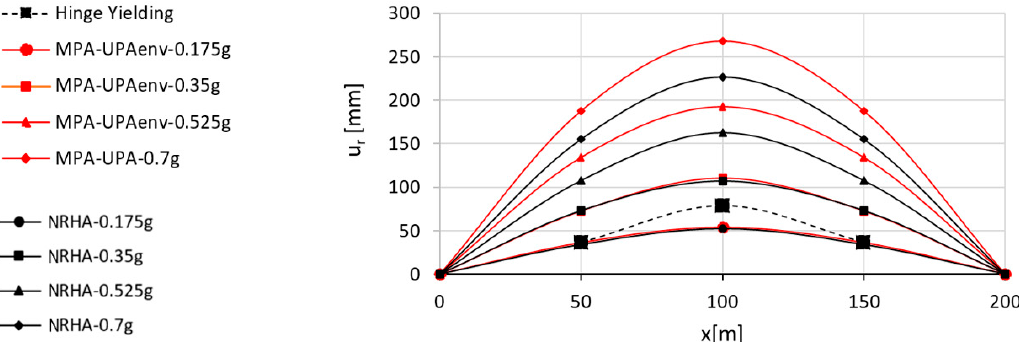
Figure 15. Regular bridge—deck displacements derived by performing nonlinear dynamic analysis and pushover analysis according to the approaches considered (PGA from 0.175 to 0.7 g).